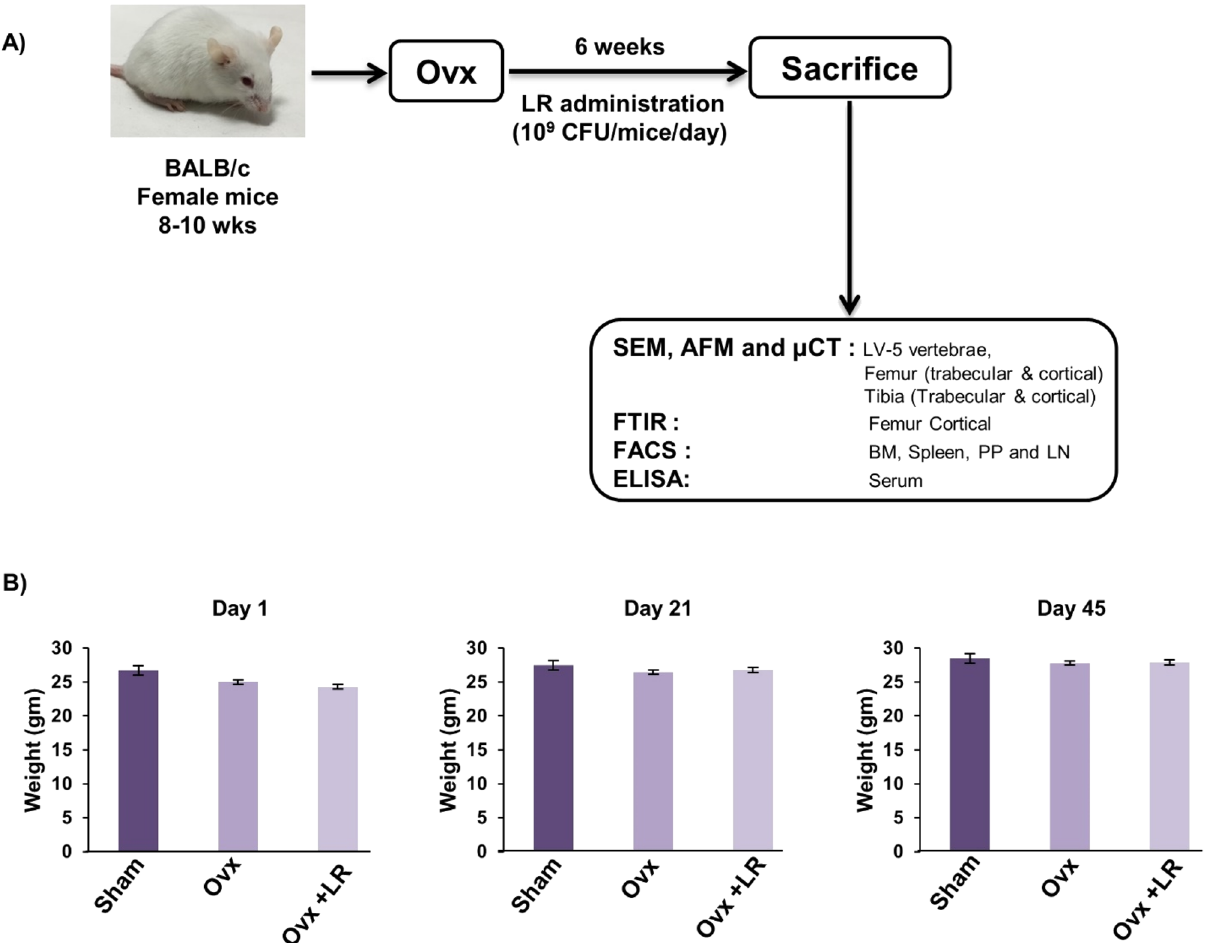
Figure 3. Experimental work plan for in vivo experiments. ( A ) Mice were divided into 3 groups. viz. Sham group, Ovx and Ovx+LR received LR. At the end of experiment (D45), mice were sacrificed and further studies performed (Mouse Image courtesy: Leena Sapra). ( B ) Effect of Lactobacillus rhamnosus (LR) on body weight; values are reported as mean ± SEM (n =